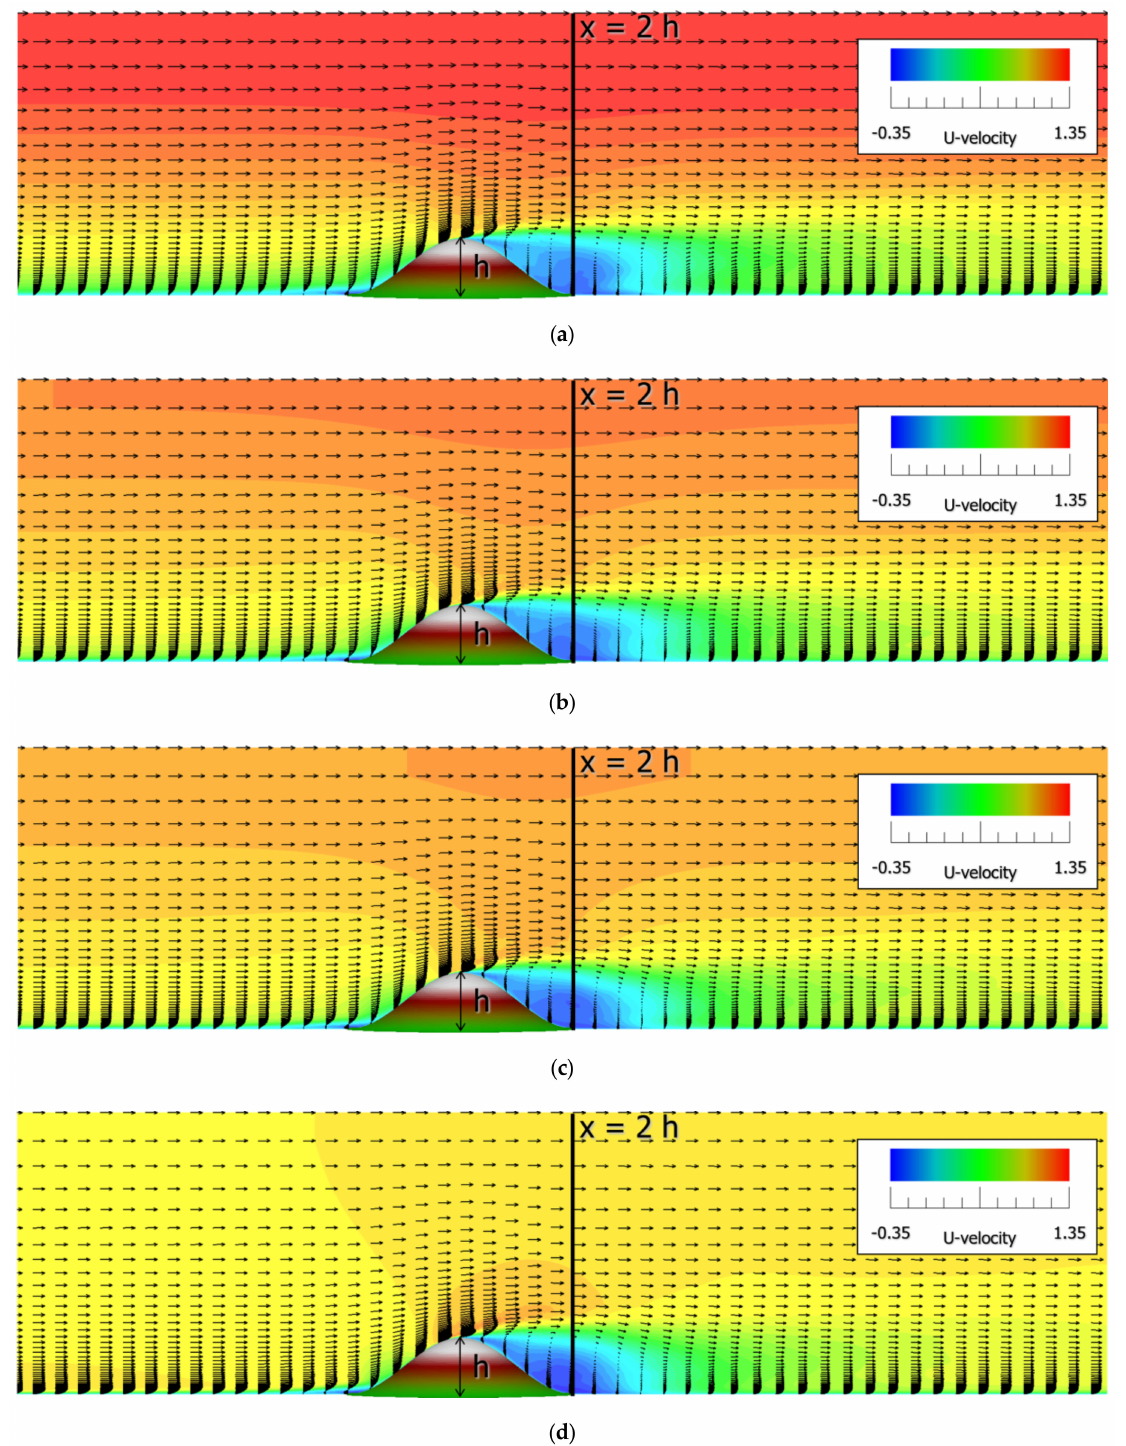
Figure 7. Comparison of flow patterns for a time-averaged flow field under various inflow conditions in the case of the steep hill scenario. ( a ) Power law index N = 4; ( b ) Power law index N = 7; ( c ) Power law index N = 10; ( d ) Uniform